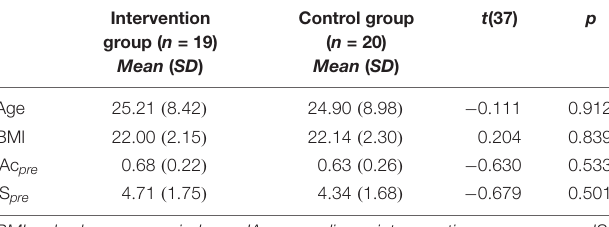
TABLE 1 | Descriptive statistics at baseline (T1) per